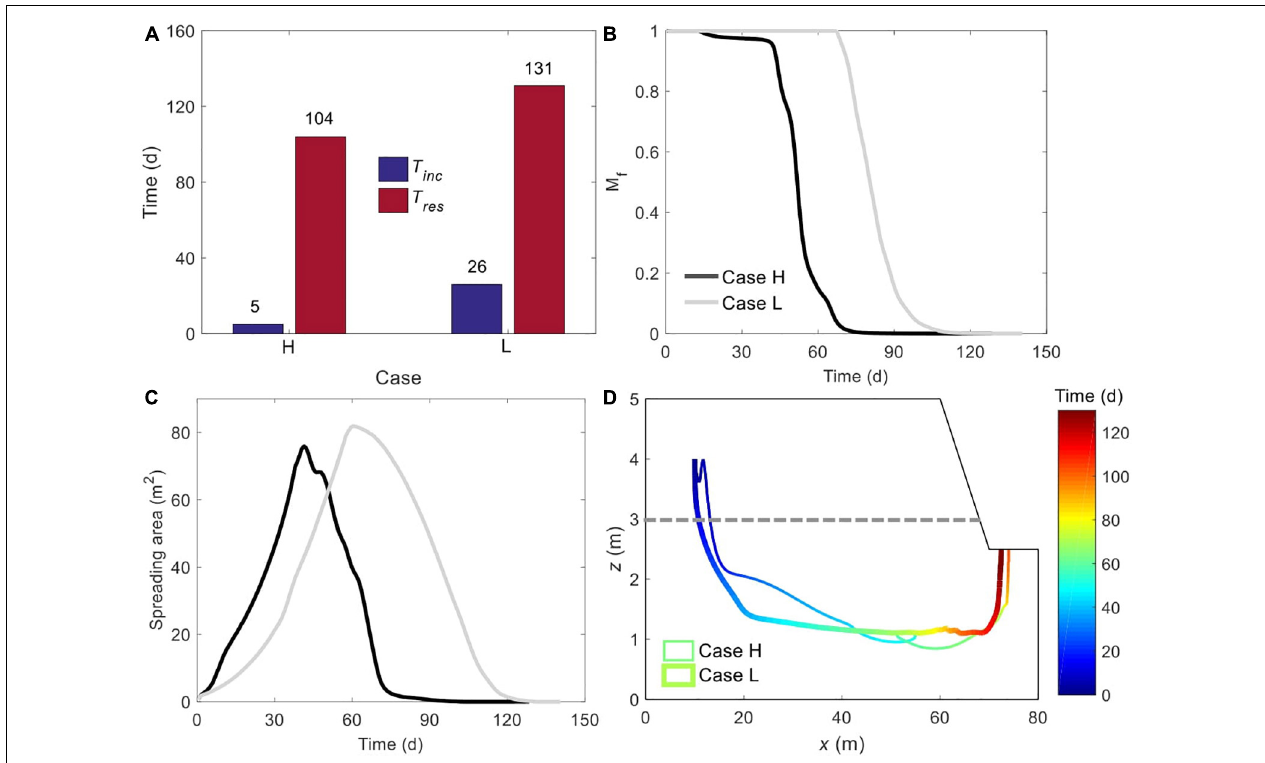
FIGURE 5 | Comparison of (A) initiation time of unstable flow and residence time of solute plume, (B) time-dependent, normalized amount of solute mass remaining in marsh soil, (C) plume spreading area, and (D) spatiotemporal variation of plume centroid between Cases H and L. The plume edge was determined based on the concentration of 0.0001 C 0 . The gray dashed line in panel (D) represents the boundary between mud layer (upper) and sand layer